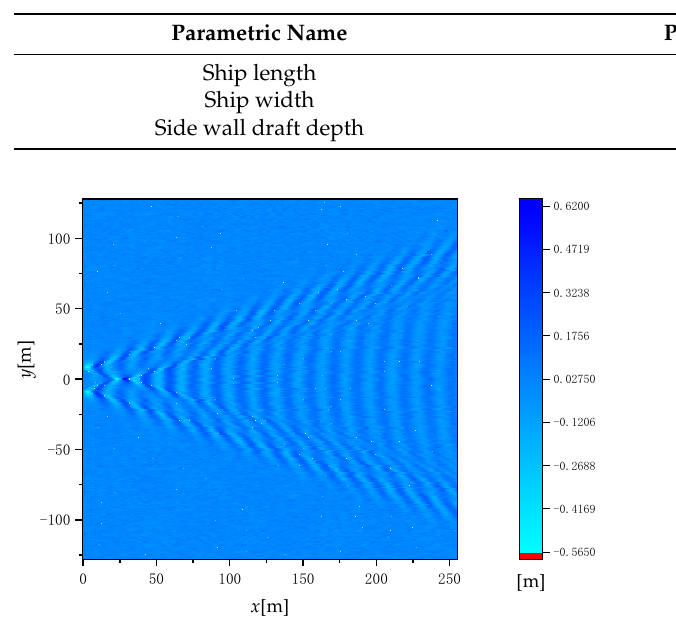
Table 1. Parameters of the Kelvin wake simulation ship.